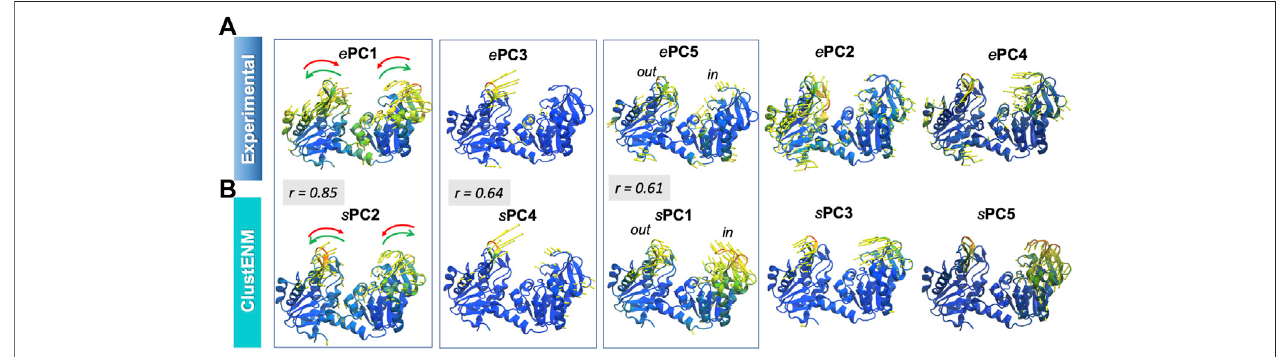
FIGURE7| First fi veprincipalmodesforPGKensembles.The (A,B) arebasedonPCAofexperimentalandClustENMensembles,respectively.ThosepairsofPCs that exhibit relatively high ( > 0.60) correlations are enclosed in boxes. See the corresponding Supplementary Movie S3